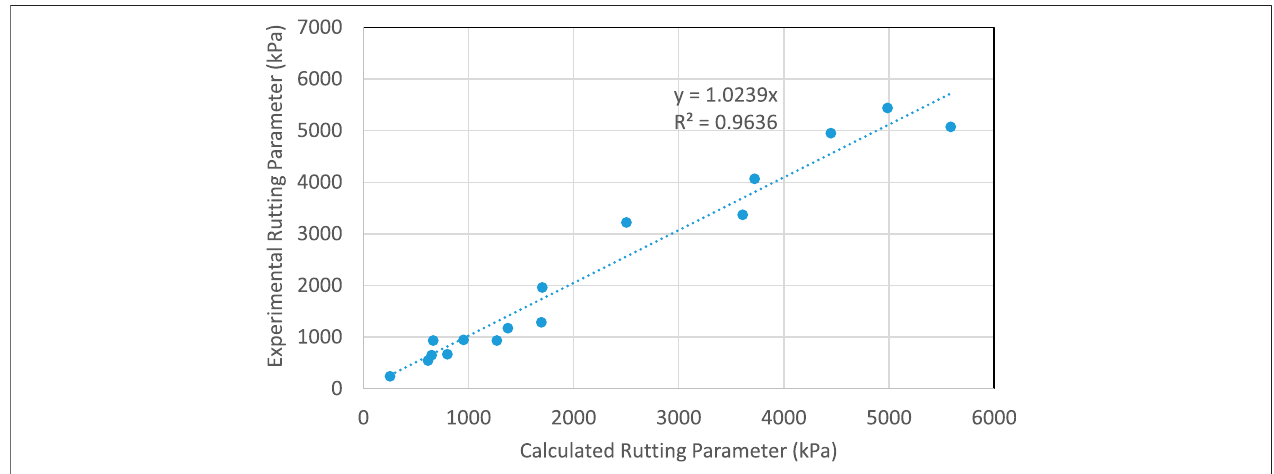
FIGURE 13 | Predicted vs. experimental rutting parameter for the aged modi fi ed CMAs: Testing (Validation) points.